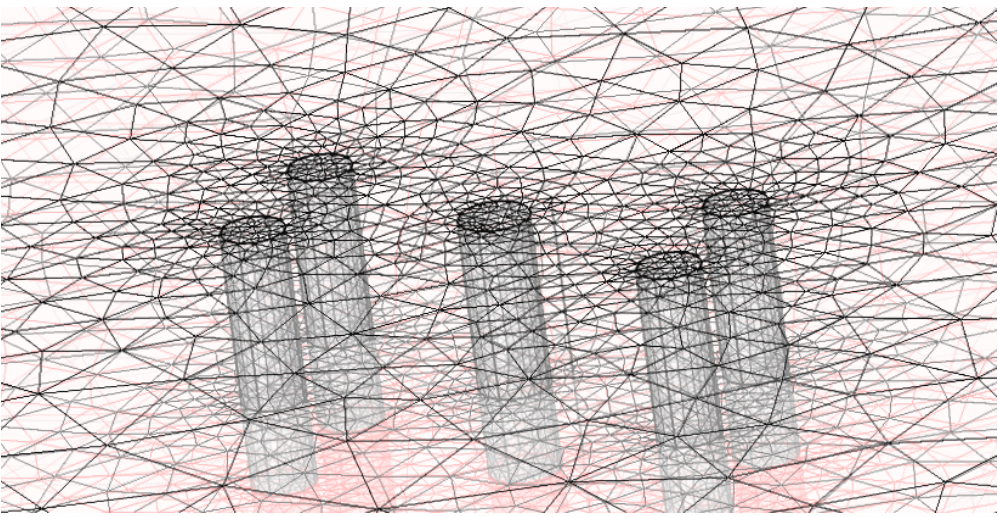
Figure 3. Meshing of the Lambeth College model.